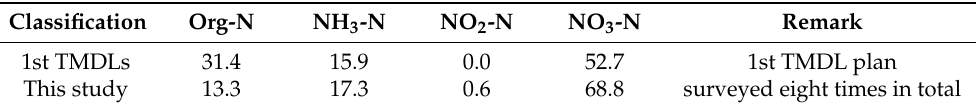
Table 7. Nitrogen ratio (%) by the type of STP applied when the TMDL was planned compared with values from this study.